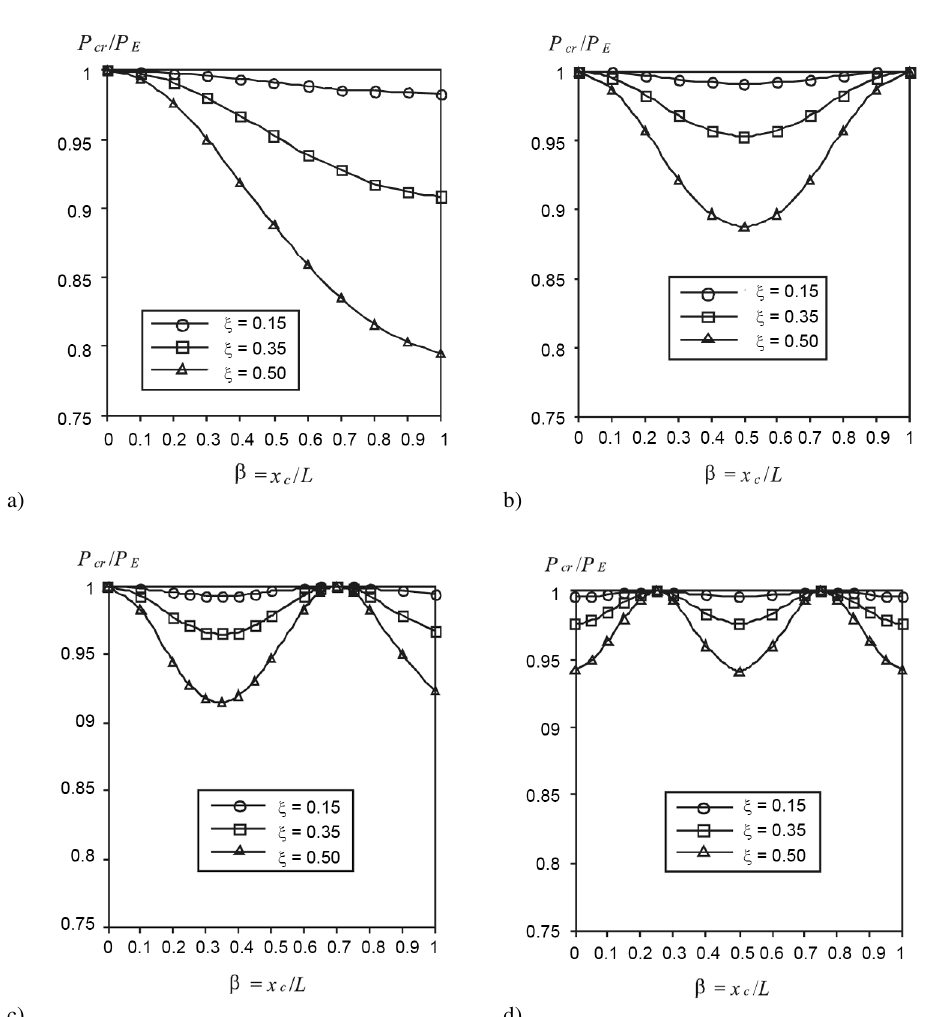
Fig. 5. Variation of the first critical buckling load to the Euler buckling load ratio ( P cr / P E ) depend- ing on the dimensionless crack depth ( ξ ) and the dimensionless crack location ( β ): (a) fixed-free; (b) pinned-pinned; (c) fixed-pinned; and (d) fixed-fixed supported rods